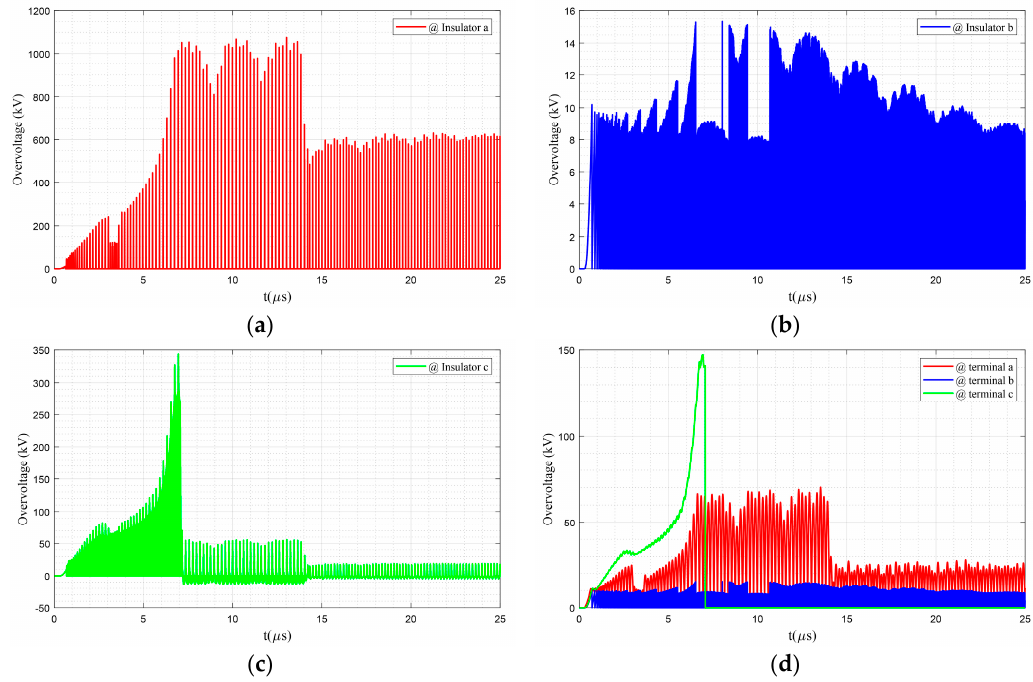
Figure 9. Flashover occurrence across ( a ) insulator a, ( b ) insulator b, and ( c ) insulator c, and ( d ) performance of the spark gap of the same pole against lightning impulses.